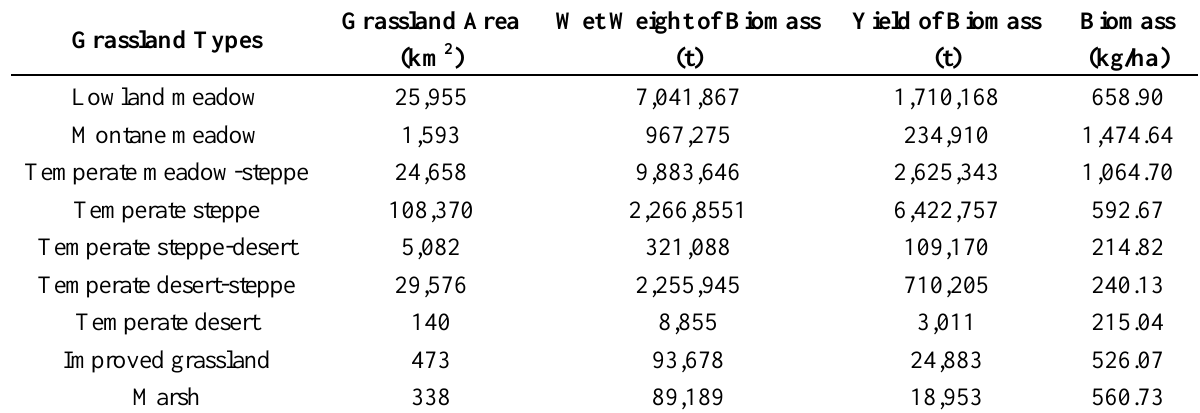
Table 5. The annual biomass of various grassland